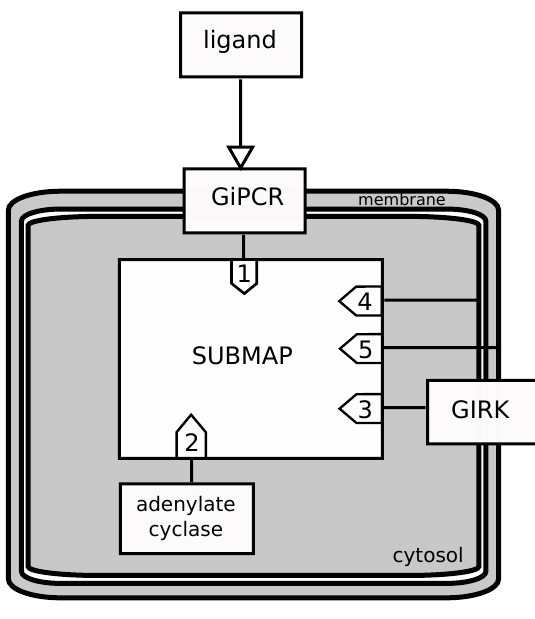
Figure 2.13: Example of a submap with contents elided.